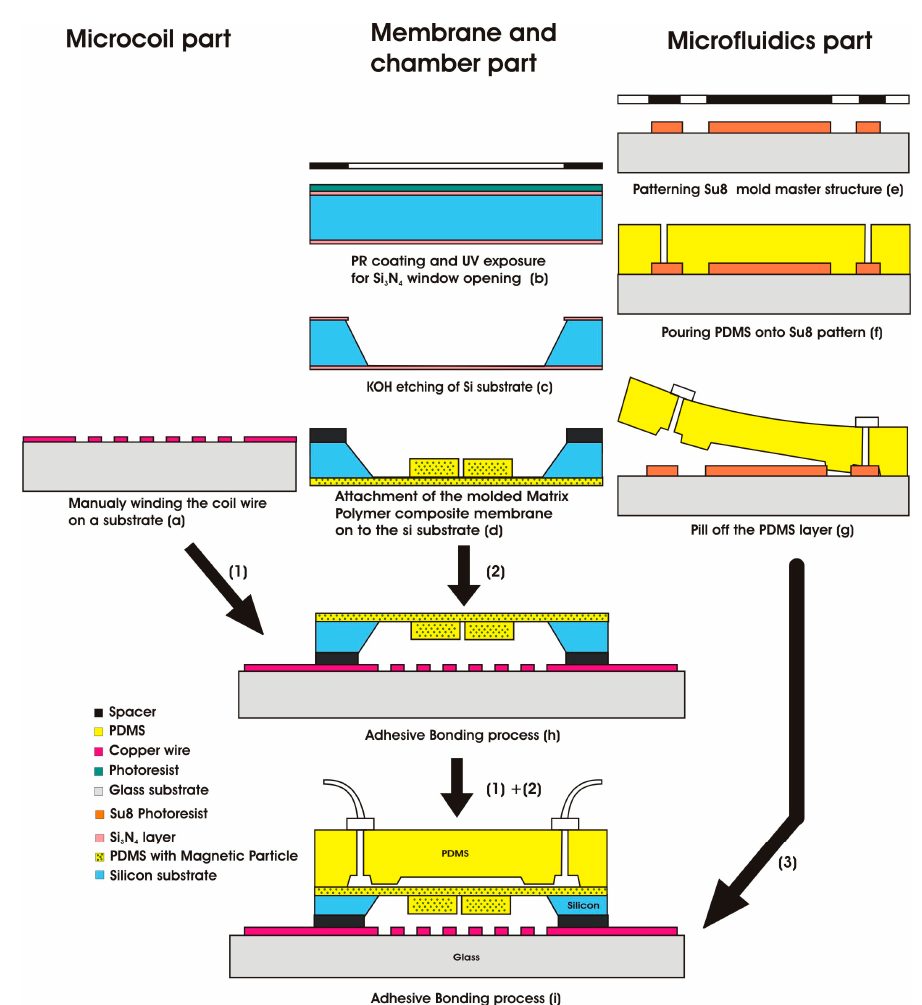
Figure 6. The fabrication process of the EM pump.